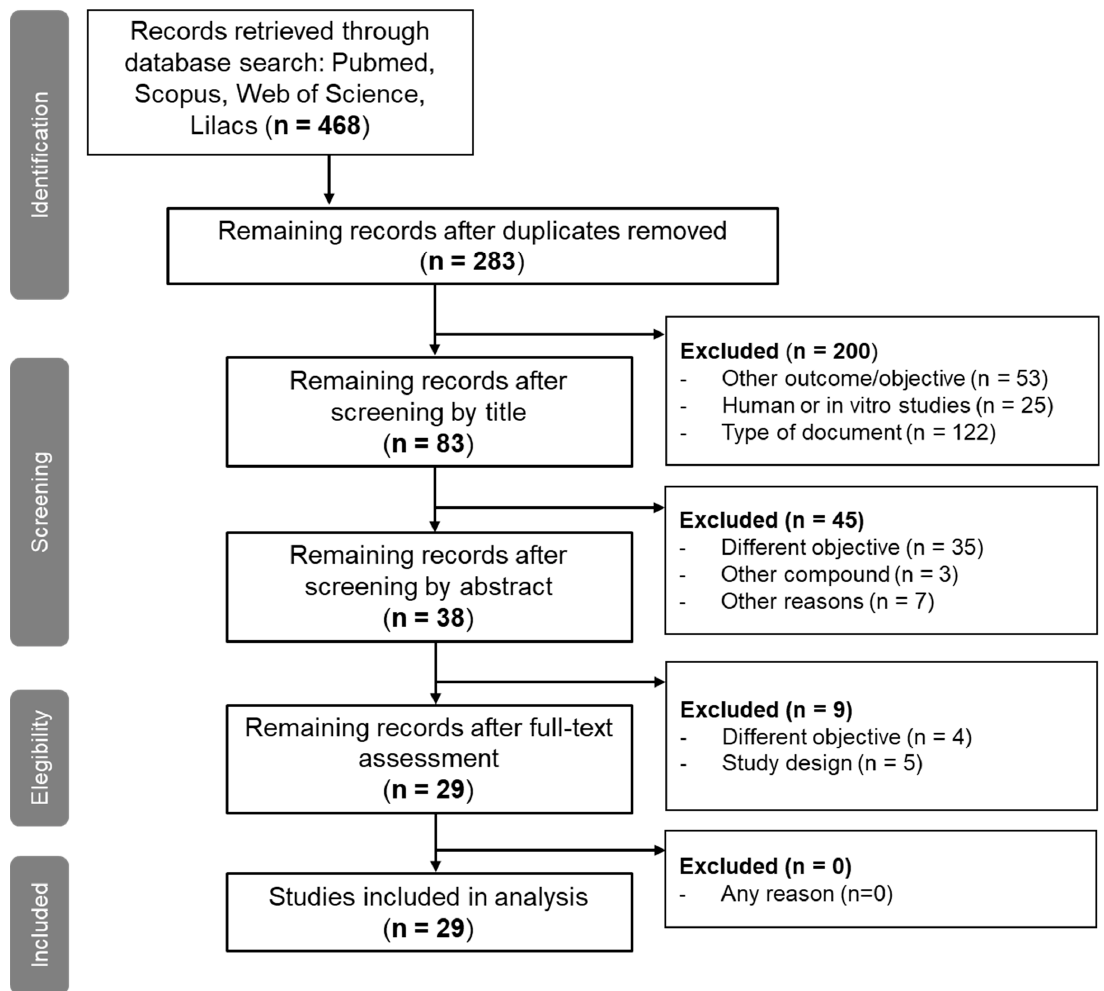
Figure 1. PRISMA flowchart of the selection process of articles that fulfilled the criteria.